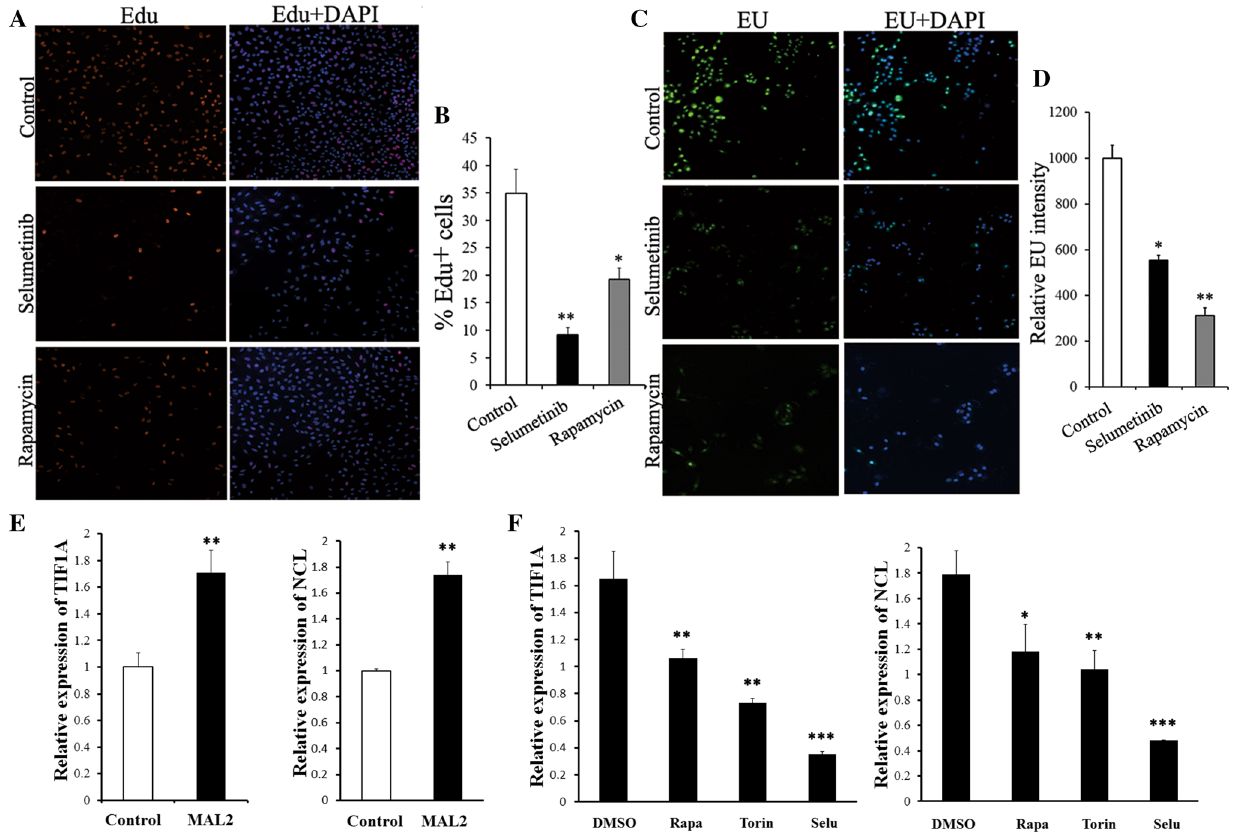
Fig. 5 Ribosome biogenesis inhibition correlates with reduced cell proliferation. A , C A549 cells with MAL2 overexpression treated with or without 10 µmol/l selumetinib or 100 nmol/l rapamycin for 48 h before analysis of DNA synthesis (EdU, red) and rRNA synthesis (EU, green). B , D EdU and EU quantifications from A and C . Data are mean ± SEM of three replicates; t-test, *p < 0.05, **p < 0.01. E MAL2 overexpression induced TIF1A and NCL transcription. qRT-PCR showing increase of TIF1A and NCL expression in A549 cells with overexpression of MAL2. Data are presented as mean ± SEM of three replicates; t-test, **p < 0.01. F The mTOR- and MEK-specific inhibitors reduced TIF1A and NCL transcription. A549 cells with overexpression of MAL2 were treated for 48 h with rapamycin, torin and selumetinib. The TIF1A and NCL tran- scription were detected by qRT-PCR. Data are presented as mean ± SEM, n = 3. *p < 0.05, **p < 0.01, ***p <